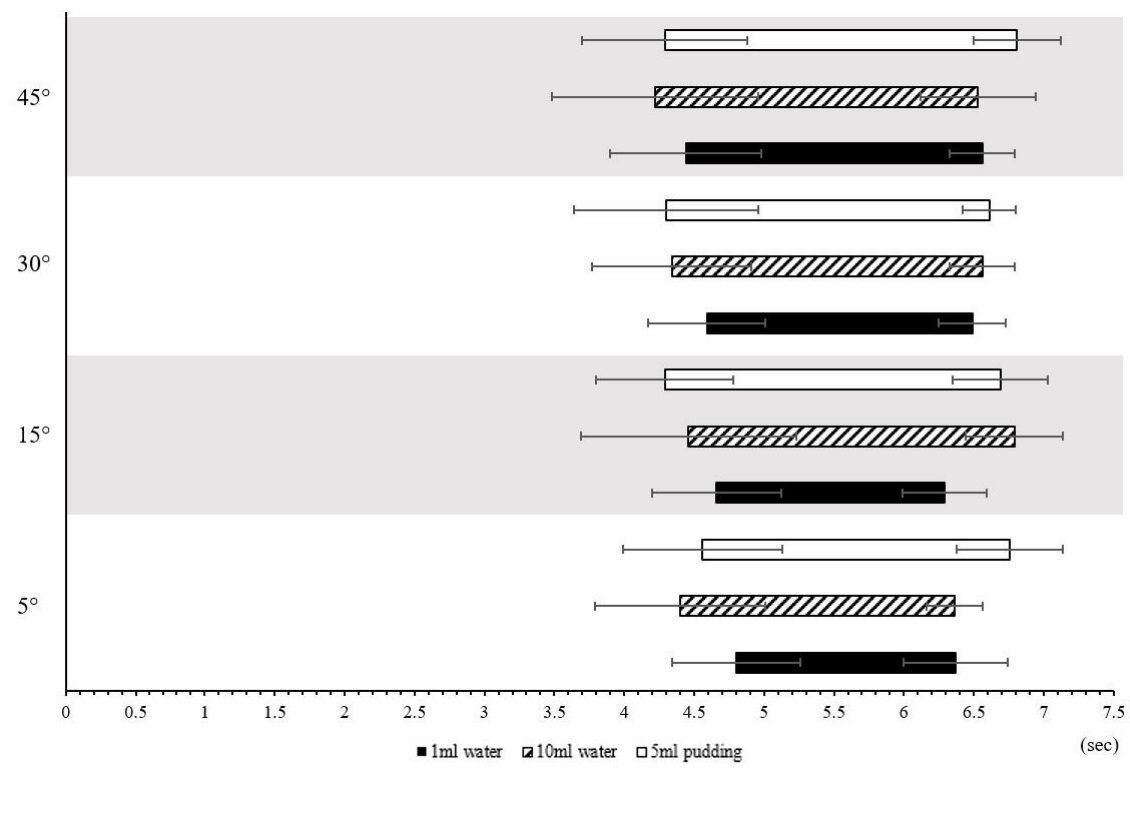
Figure 4. Comparisons among four different trunk inclinations and three different food types: ( a ) D sEMG ; ( b ) SAD; ( c ) TET; ( d ) FSR amplitude; ( e ) D2DEF; ( f ) onset latency; ( g ) duration between FSR onset – offset. * p < 0.05.